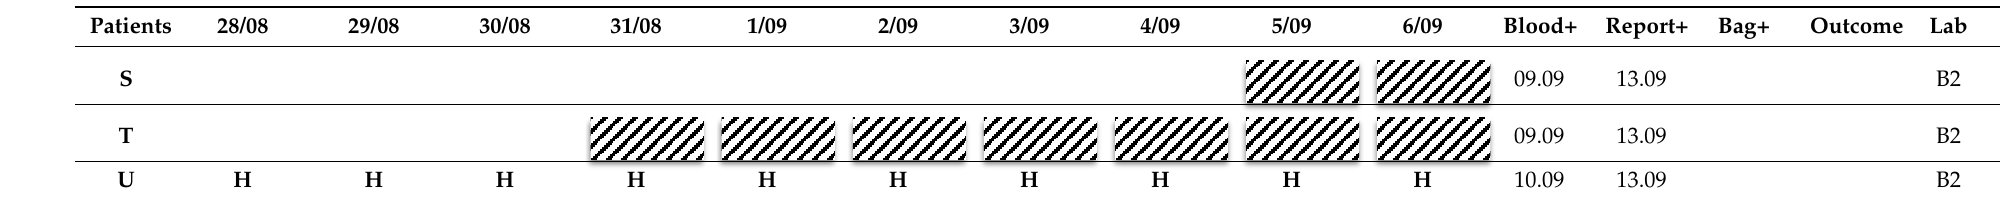
Table 4 summarize the most relevant data for each patient. Table 4. Patients, date of administration of Total Parenteral Nutrition in the hospital (marked with diagonals) or at home (H), date the bloodwork tested positive (blood +), date of the report (report+), date the bag tested positive (bag+), outcome, and laboratory that performed the analyses (B1 = Bacteriology 1, B2 = Bacteriology 2).